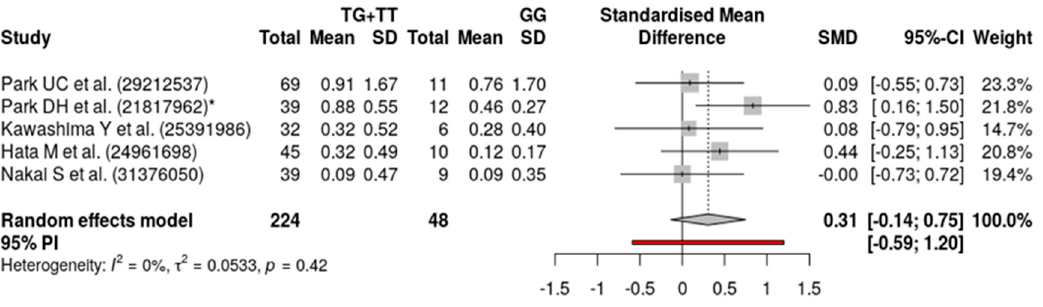
Figure 3. Forest plot of the meta-analysis showing the association between ARMS2 A69S (rs10490924) and treatment response to anti-VEGF agents in PCV patients using random-effects models. Dominant model for allele T (TG + TT vs. GG).